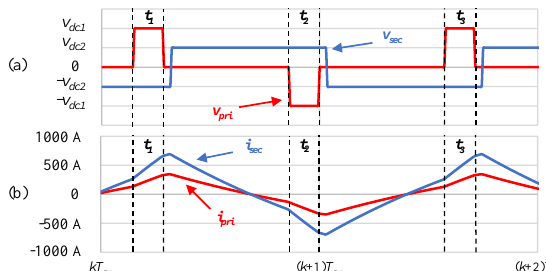
Figure 15. Waveforms in the primary and secondary sides of the HF transformer when the DAB operates under EPS modulation: (a) Voltage; (b) Current.